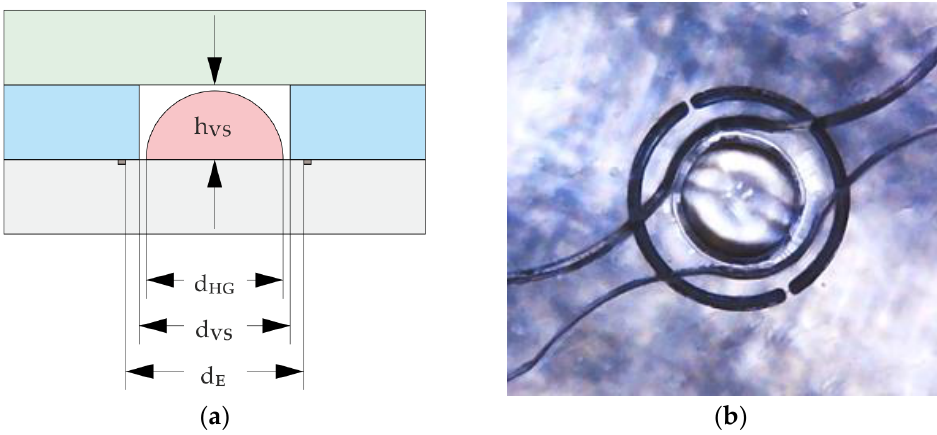
Figure 3. ( a ) Schematic cross-section of closing valve layer stack; pink — hydrogel element, blue — fluidic layer; the width of the hydrogel, d HG ; the diameter of the valve seat, d VS ; the diameter of the engraving, d E ; thickness of the foil of fluidic layer, h VS . ( b ) Top view of dry hydrogel positioned in 475 µm diameter (d VS ) valve seat and 600 µm diameter (d E ) engraving.